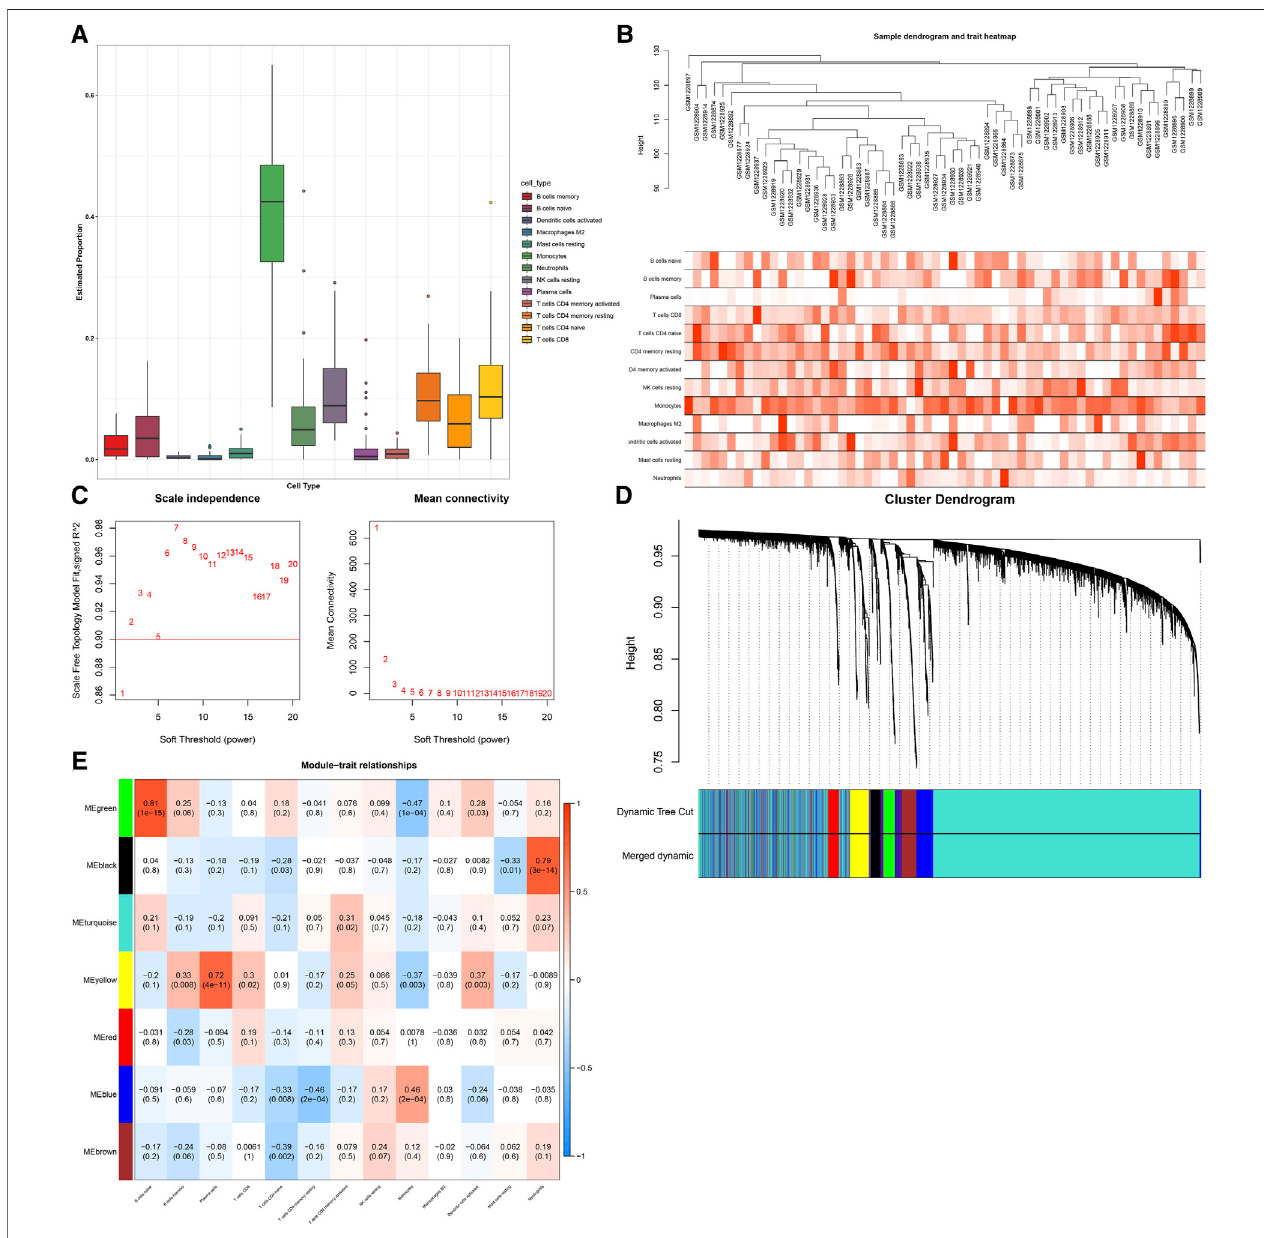
FIGURE1 | Establishment ofimmunecell-relevant co-expression modules with WGCNA approach. (A) Quanti fi cation of theabundance ofdiverseimmune cells in SLE specimens through the CIBERSORT approach. (B) Sample clustering for detecting outliers. (C) Determining soft-thresholding power ( β ) through analyses of (left) scale-free fi tindexand(right)meanconnectivity. (D) Dendrogramofconsensusmoduleeigengenes.Genedendrogramisgeneratedfollowingclusteringthedissimilarity. (E) Heatmapoftheassociationbetweendiverseimmunecellsandmoduleeigengenes.Eachrowandcolumnseparatelyindicateaconsensusmoduleandimmune cells. Thecells are colored in linewith thecorrelation(red: positive correlation; blue, negative correlation). The intensity ofthe color re fl ects the strength of thecorrelation.